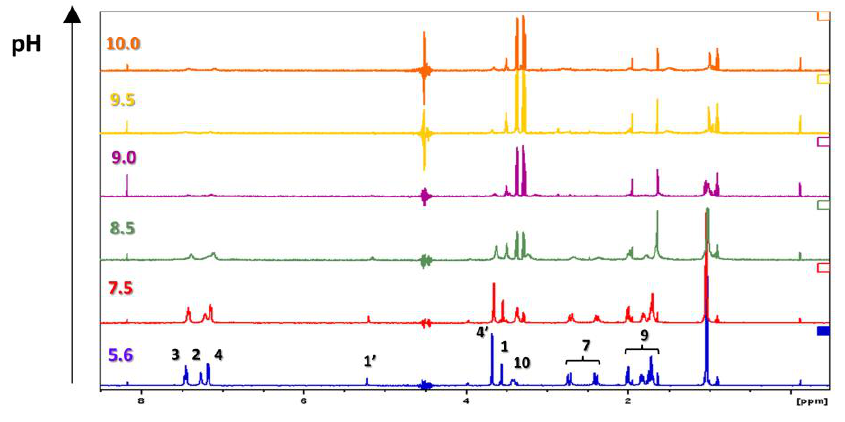
Figure 4. 1 H NMR spectra at different pH (c = 1.0 mg/mL, 50/50 vol% H 2 O/D 2 O).